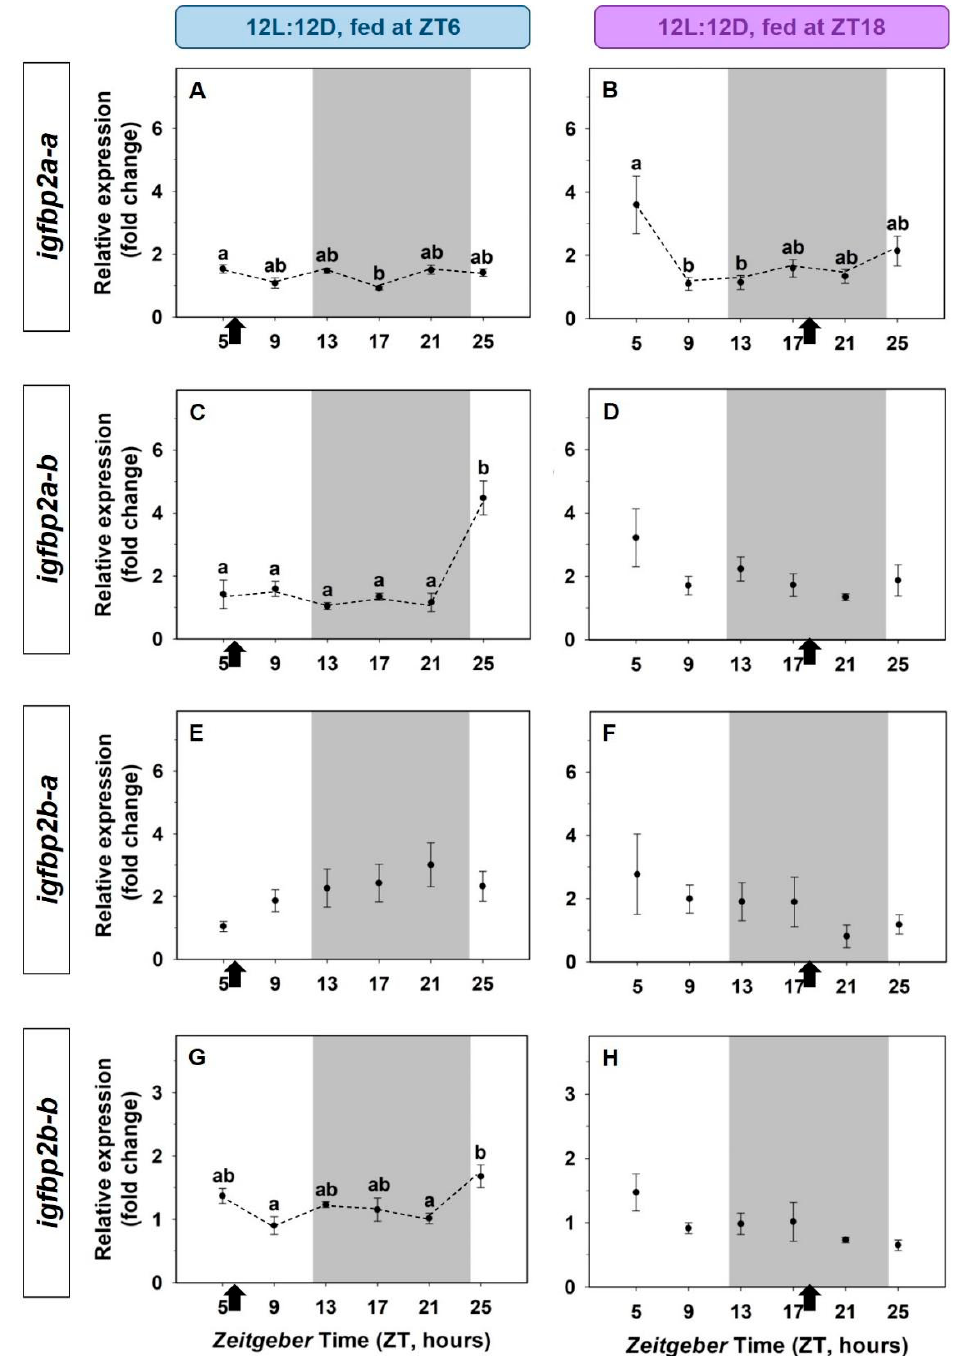
Figure 7. Effect of a shifted mealtime on the daily expression of igfbp2 paralogs in the liver of goldfish. ( A , B ) igfbp2a-a ; ( C , D ) igfbp2a-b ; ( E , F ) igfbp2b-b ; ( G , H ) igfbp2b-a . On the right ( A , C , E ), fish fed at mid-photophase, ZT6); on the left ( B , D , F ), fish fed at mid-scotophase, ZT18. Data are expressed as mean ± s.e.m. ( n = 7/sampling time). Different letters indicate statistical differences among sampling points (ANOVA). Dashed lines represent significant differences among sampling points by ANOVA. Black arrows indicate feeding time. The dark period is represented in grey. As a rule, the expression of the four paralogs of the igfbp2 did not fit sinusoidal 24-h rhythms, but some statistically significant differences were found through the 24-h cycle (Figure 7). The number of transcripts of igfbp2a-b and igfbp2b-b was significantly higher at